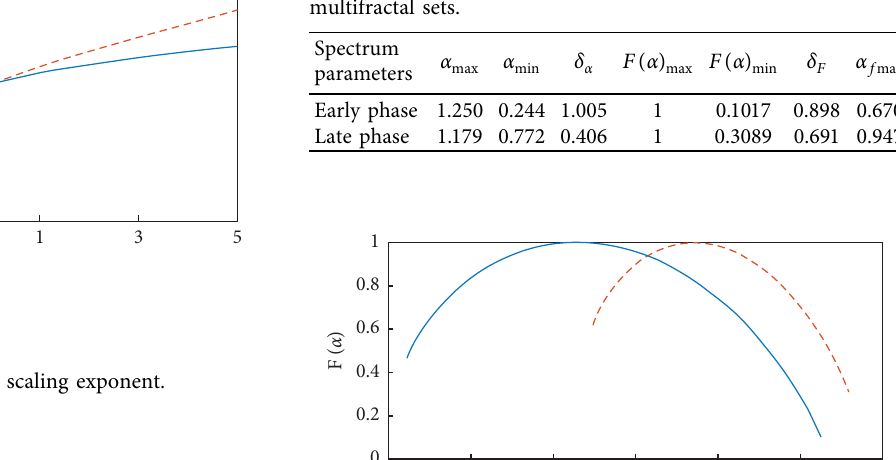
Table 3: Scale index of the nonlinear vibration signal of the cyl- inder block.